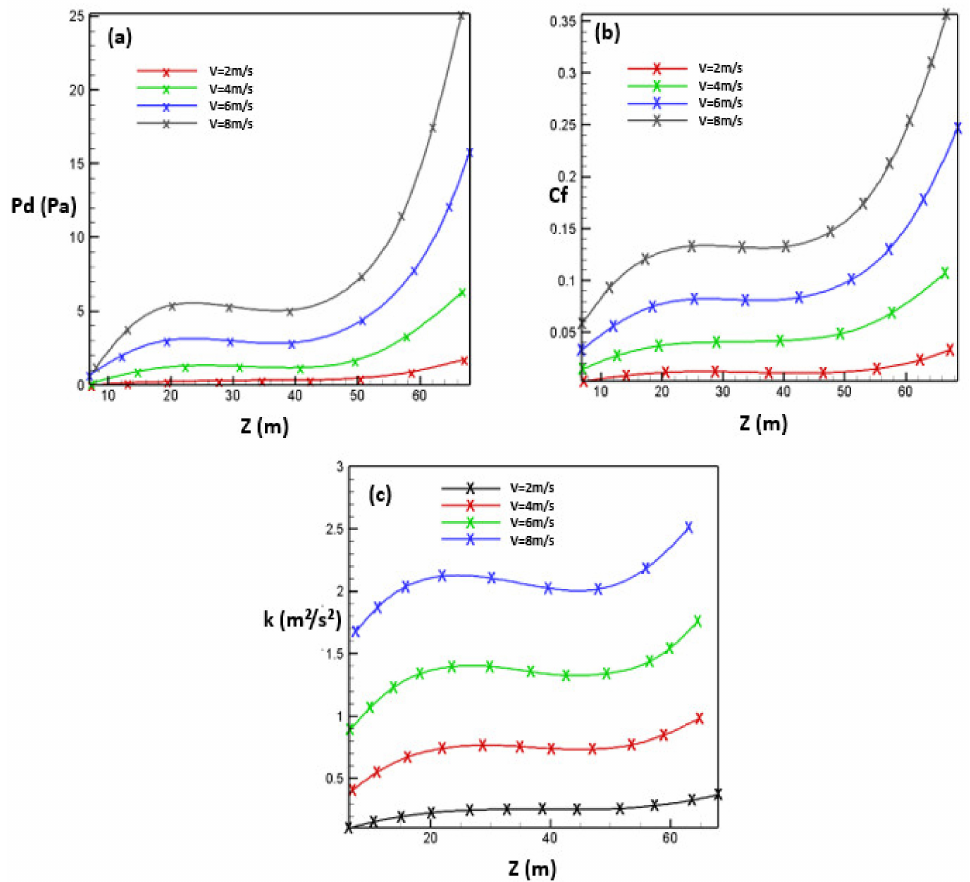
Figure 11. Dynamic pressure ( a ), friction coefficient ( b ), and the turbulent kinetic energy ( c ) as function of altitude